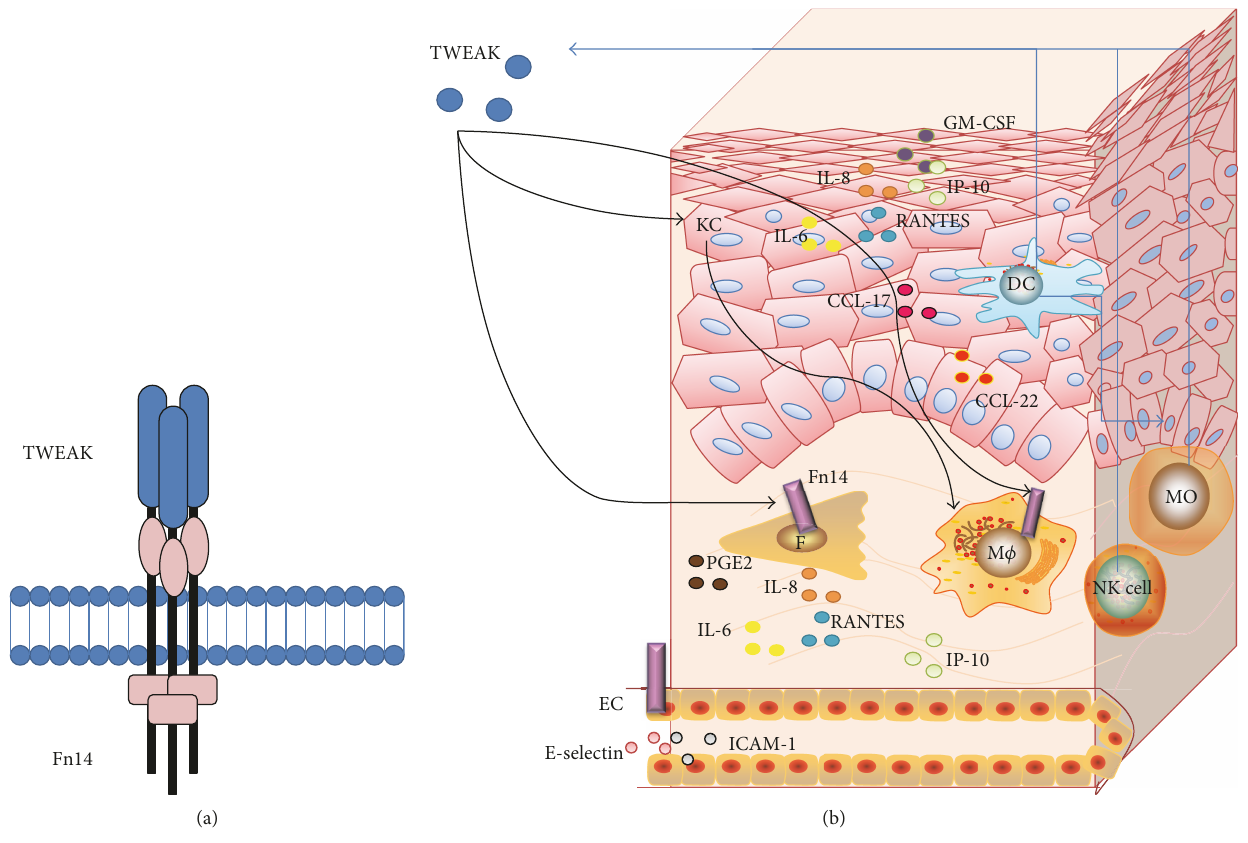
Figure 1: The diagram for TWEAK, Fn14, and relevant cytokines in skin structure. (a) The structures of TWEAK and Fn14 partners. (b) Fn14 is expressed on multiple cell types, including keratinocytes (KC), dermal fi broblasts (F), macrophages (M ϕ ), and microvascular endothelial cells (EC). Intracellular TWEAK protein is expressed by monocytes (MO), dendritic cells (DC), and natural killer (NK) cells. TWEAK induces keratinocytes to express proin fl ammatory cytokines, such as IL-6, IL-8, RANTES, GM-CSF, IP-10, CCL17, and CCL22, which promote the migration of macrophages. TWEAK also induces the production of IL-6, IL-8, RANTES, IP-10, and PGE2 in dermal fi broblasts as well as E-selectin and ICAM-1 in microvascular endothelial